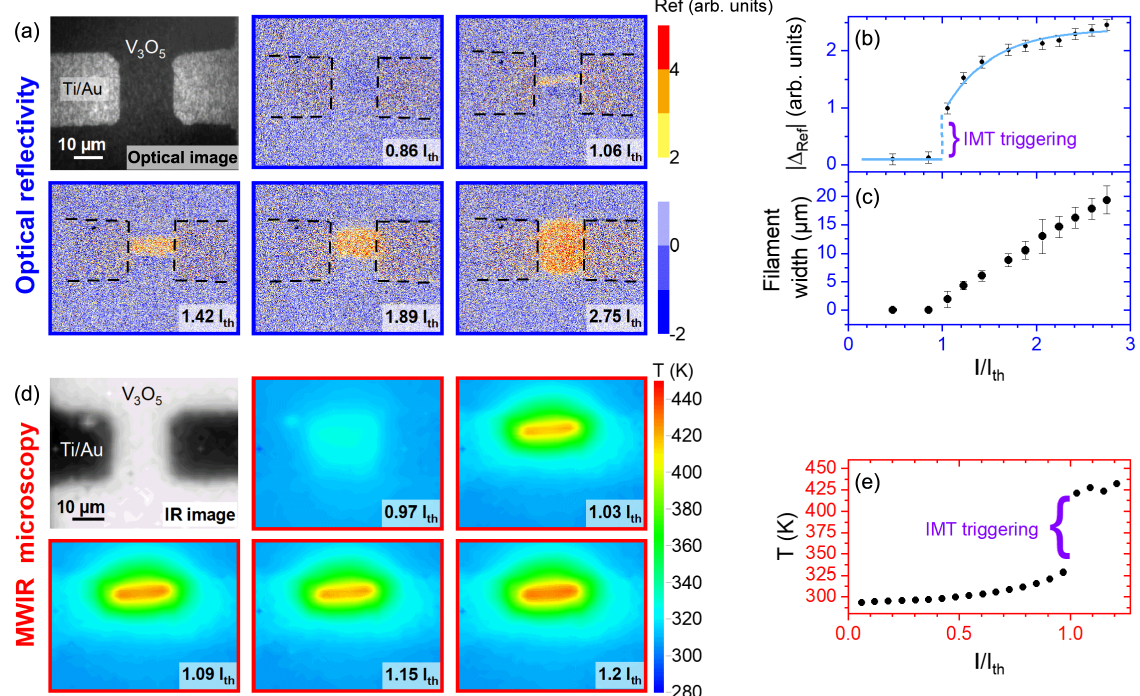
FIG. 3. Optical imaging and MWIR temperature mapping of the resistive switching in V 3 O 5 . (a) Optical image of the V 3 O 5 device. The dark area is the V 3 O 5 film; the two bright regions are the electrodes. The gap separating the two electrodes is approximately 20 μ m. The differential contrast images of the resistive switching in V 3 O 5 (see the main text for details) show the formation of the filament that percolates between the electrodes. The low-temperature phase is in blue, and the high-temperature phase is in orange. This filament is the high-temperature phase of V 3 O 5 . (b),(c) Reflectivity change and filament width vs normalized current extracted from the optical reflectivity images. (d) IR emission image of the V 3 O 5 device (performed with a QFI Infrascope). Note that the contrast is reversed compared to the optical image in (a), which is due to low emissivity of the metal electrodes. The 2D MWIR temperature maps show the device before and after the resistive switching. The entire device area warms up before the switching. After the switching, a hot (above T c ) localized filament forms. (e) Maximum temperature vs normalized current extracted from the MWIR maps. We note that the optical reflectivity (a) and IR emission measurements (d) are performed in two different setups, and, hence, the current ranges are not exactly the